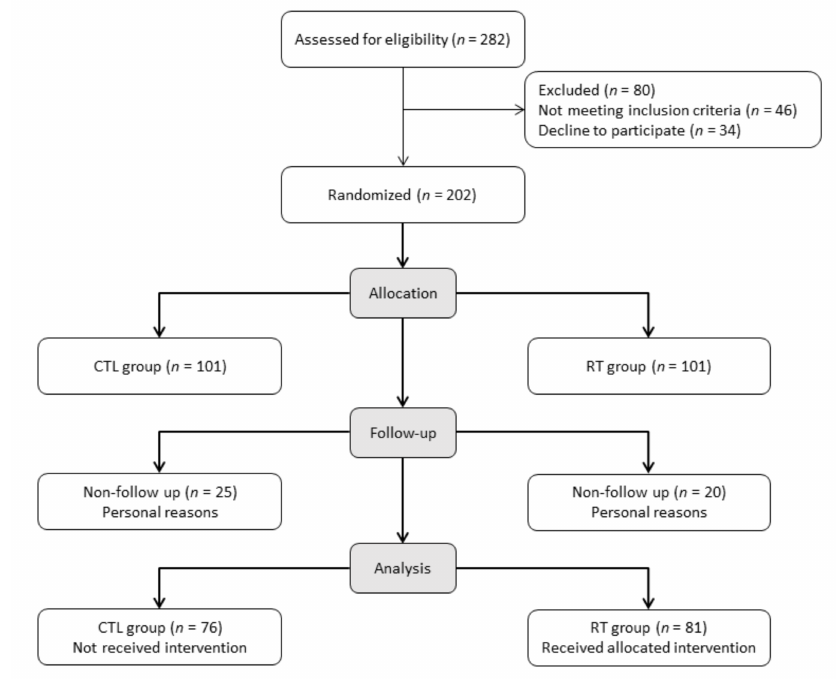
Figure 1. Participants